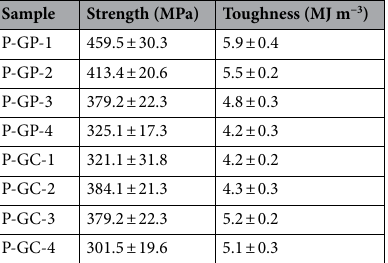
Table 4. Mechanical properties of P-GP ternary artificial nacre and P-GC ternary artificial nacre.